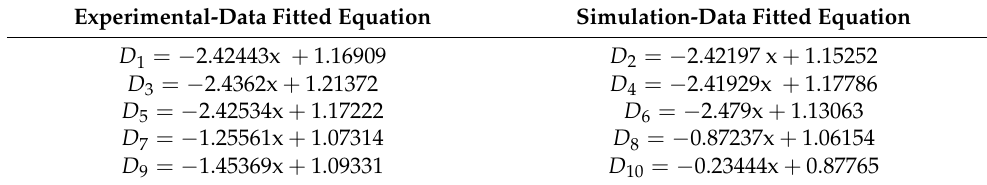
Table 3. Fitted equations for the curves in Figure